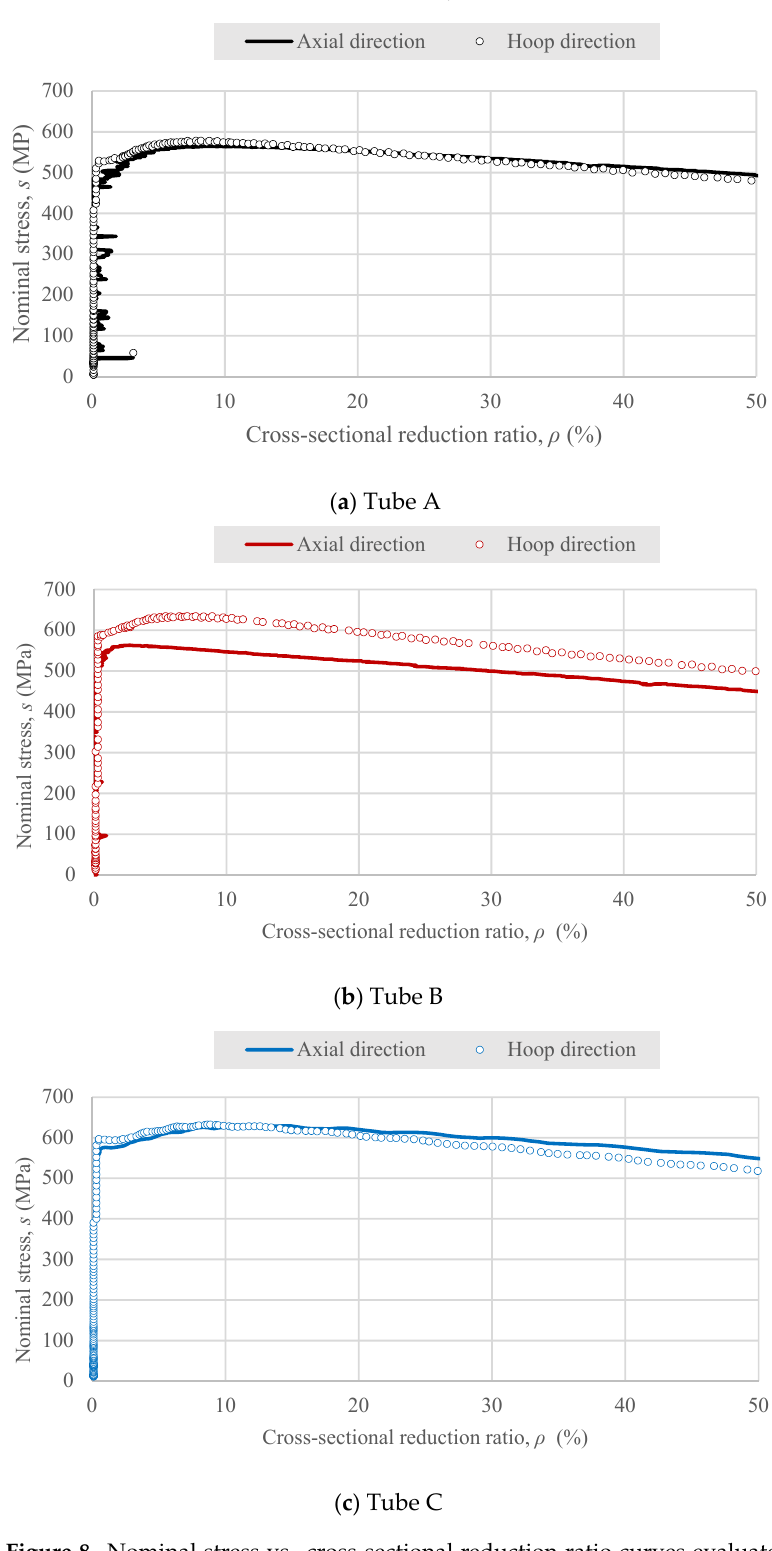
Figure 8. Nominal stress vs. cross-sectional reduction ratio curves evaluated by using the small round-bar specimens.